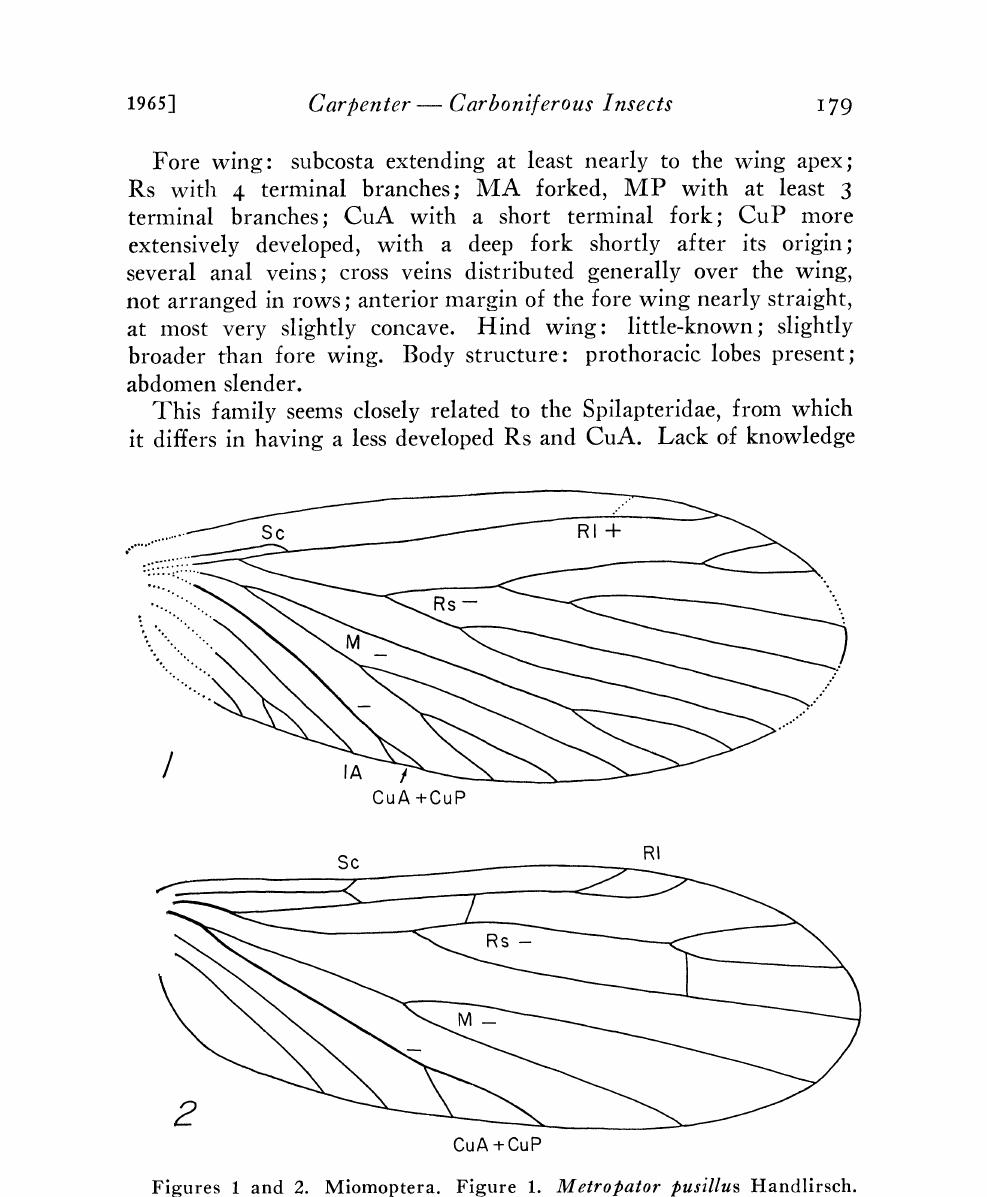
and 2. Miomoptera. Figure 1. Melropator pusillus Handlirsch. Drawing of holotype, no. 3.8731, U.S.N.M.; hind wing (original). Figure 2. Palaeomantis minuta (Sellards), hind wing (original). Lower Permian, Kansas. Lettering: Se, subcosta; R1, radius; Rs, radial sector; M, media; CuA, anterior cubitus; CuP, posterior eubitus, 1A, first anal vein; @, convex veins; --, concave